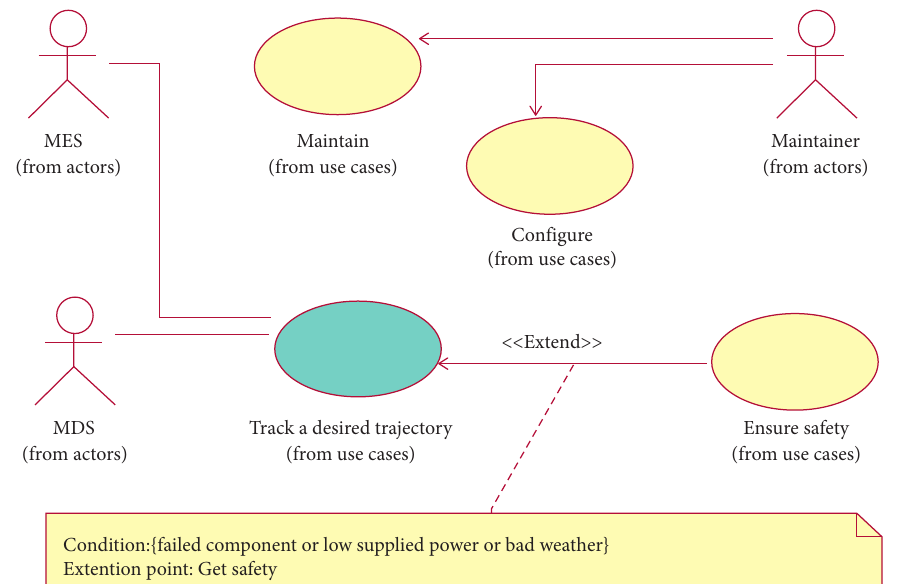
Figure 2: Use-case diagram for capturing the main control requirements of the